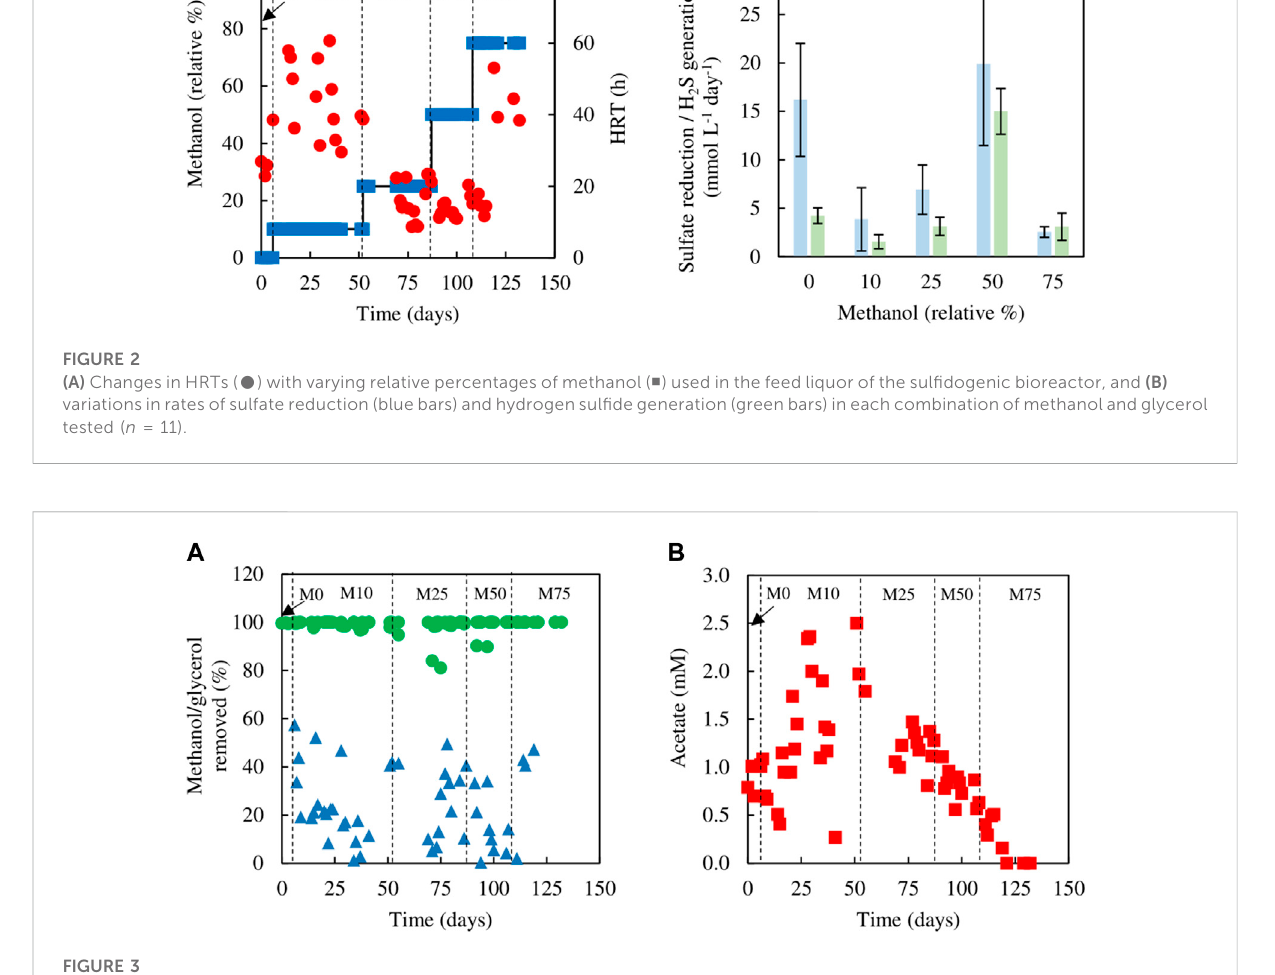
FIGURE 3 (A) Differencesinconcentrationsof (A) methanol( ▲ )andglycerol( C )removed,and (B) concentrationsofacetate( ■ )presentinef fl uentliquors, during tests carried out with mixtures of glycerol and methanol in the feed